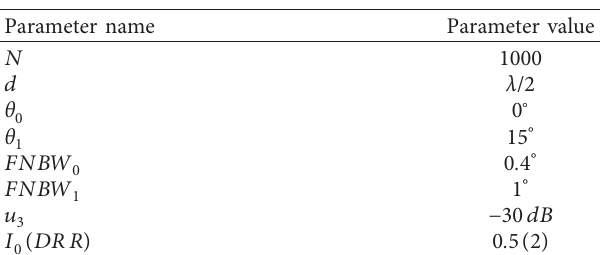
Table 1: Array parameter.